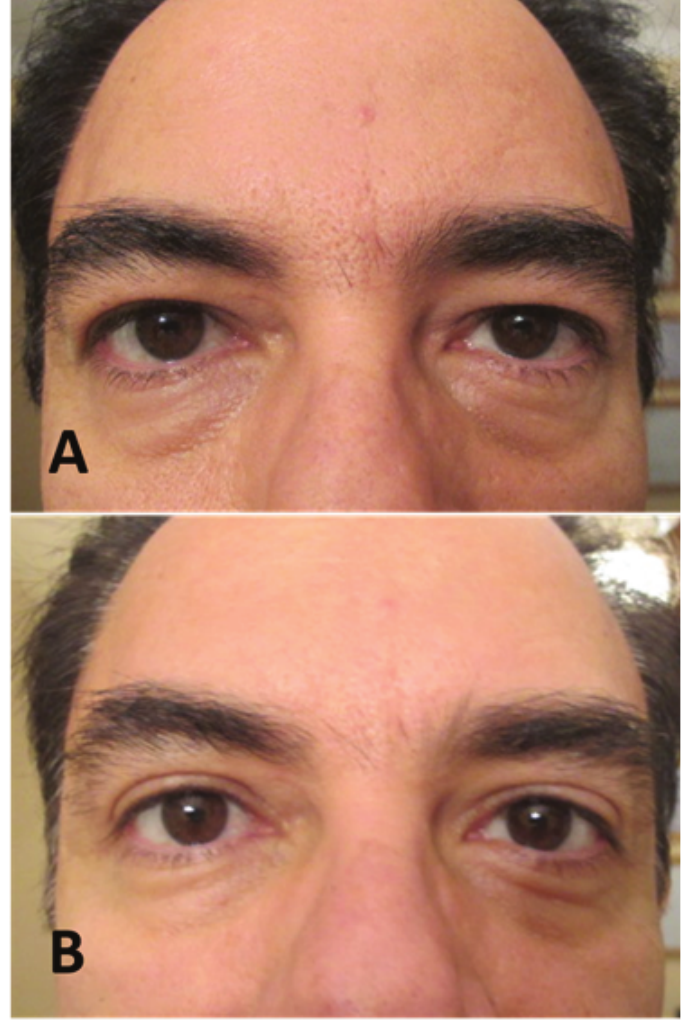
Figure 5. A subject with high hair line before (A) and after (B) direct eyebrow lift and upper blepharoplasty procedures. Direct eyebrow lift is mostly used for male with high frontal hair line which lateral eyebrow is